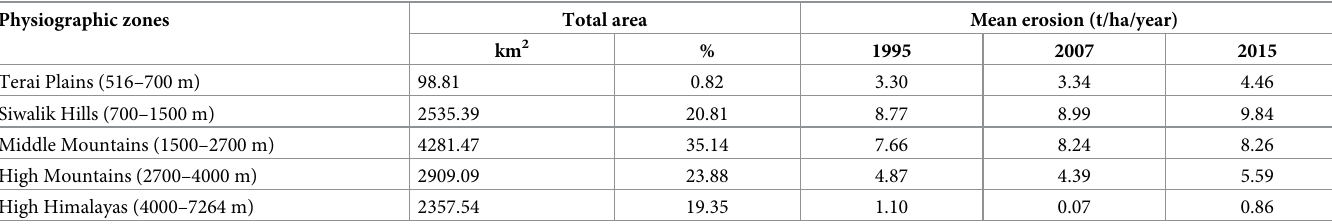
Table 7. Variation of soil loss with physiographic zones. Physiographic